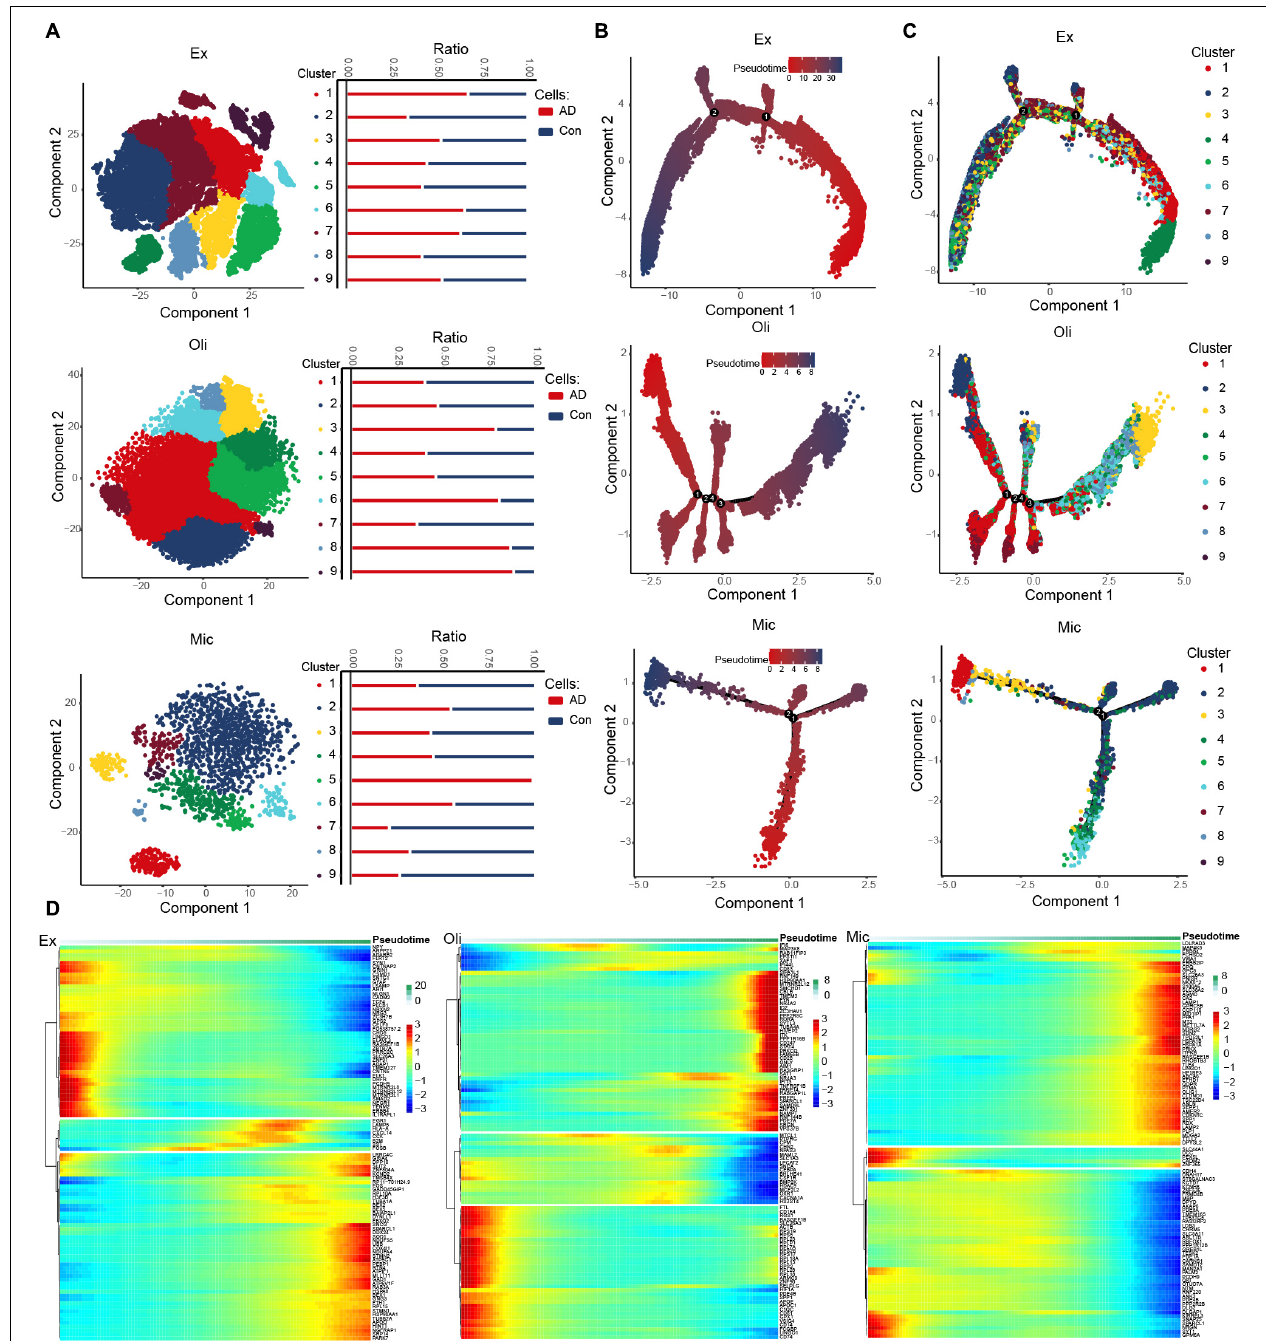
FIGURE 2 | Evolution of expression dysregulation in specific cell types during the course of AD. (A) T-distribution stochastic neighbor embedding (T-SNE) plot of excitatory neurons, oligodendrocytes and microglia cells showing nine clusters. The bar chart shows the abundance of cell subsets in individuals showing strong or no/weak AD pathology. (B) Pseudotime analysis of excitatory neurons, oligodendrocytes and microglia. Darker color indicates longer pseudotime. (C) Distribution of cells in different clusters in the trajectories of excitatory neurons, oligodendrocytes and microglia. (D) Expression distribution and heat map of genes as a function of pseudotime. Genes showing similar expression trends fell into distinct clusters.